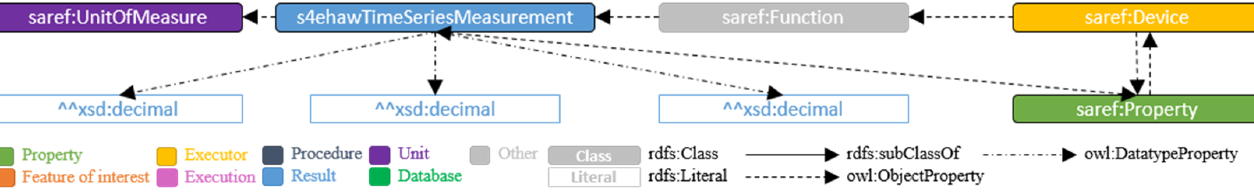
Figure 15. Storing time-series measurements as an array of xsd:float values using SAREF4health.